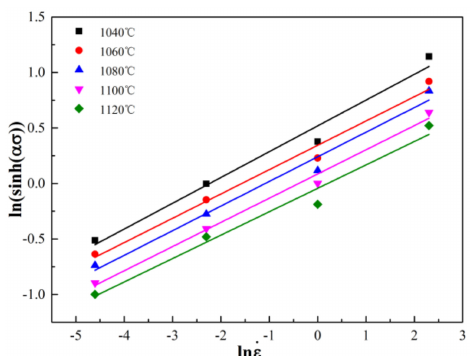
Figure 4. The relationship between σ and ln